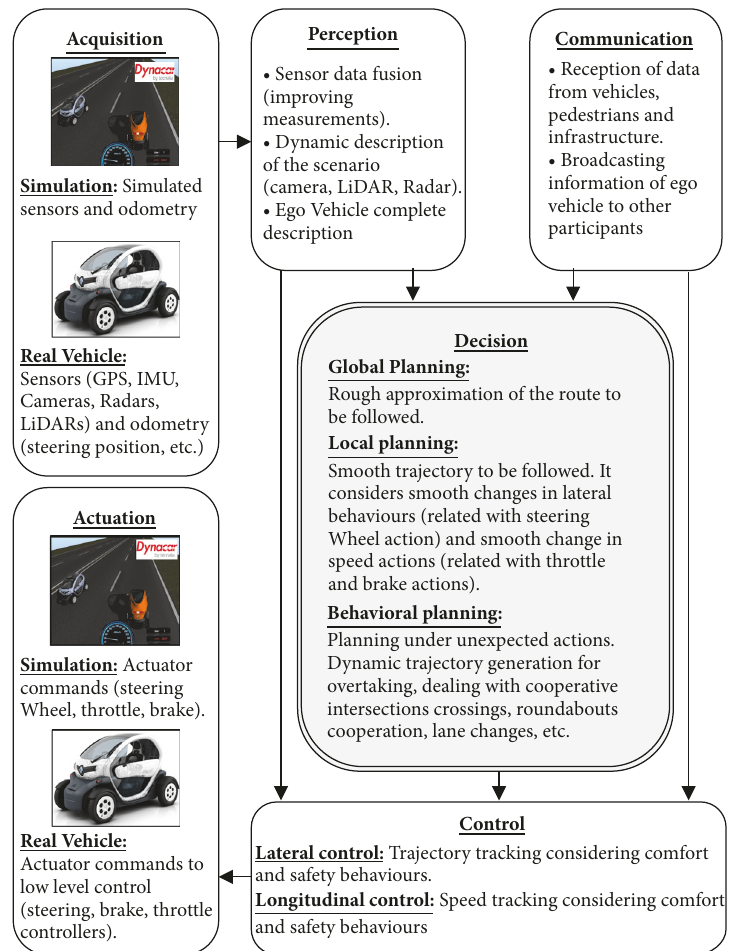
Figure 8: Control architecture of automated